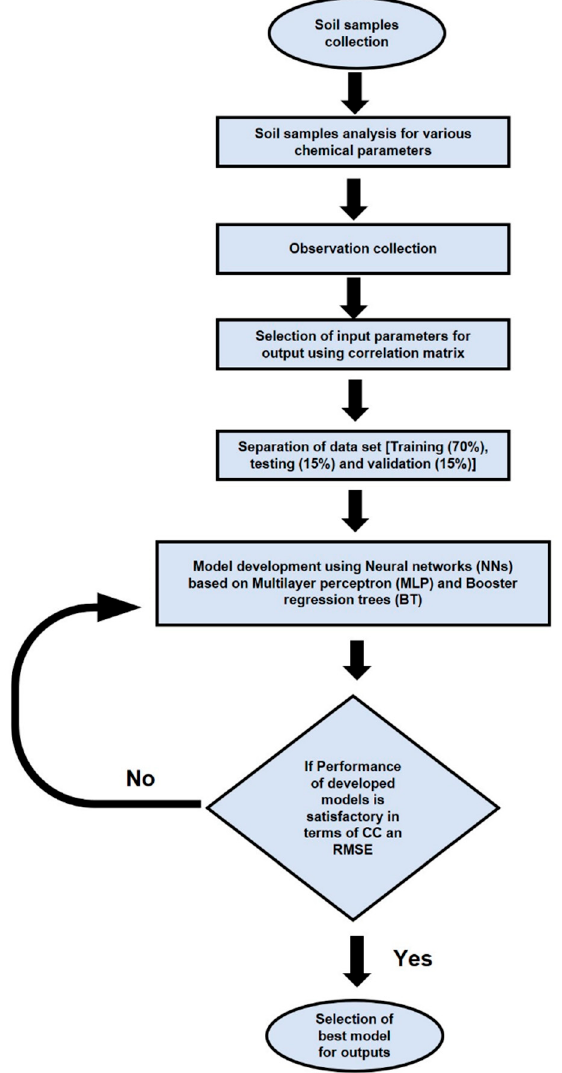
Figure 2. Flowchart of the work carried out in this paper.